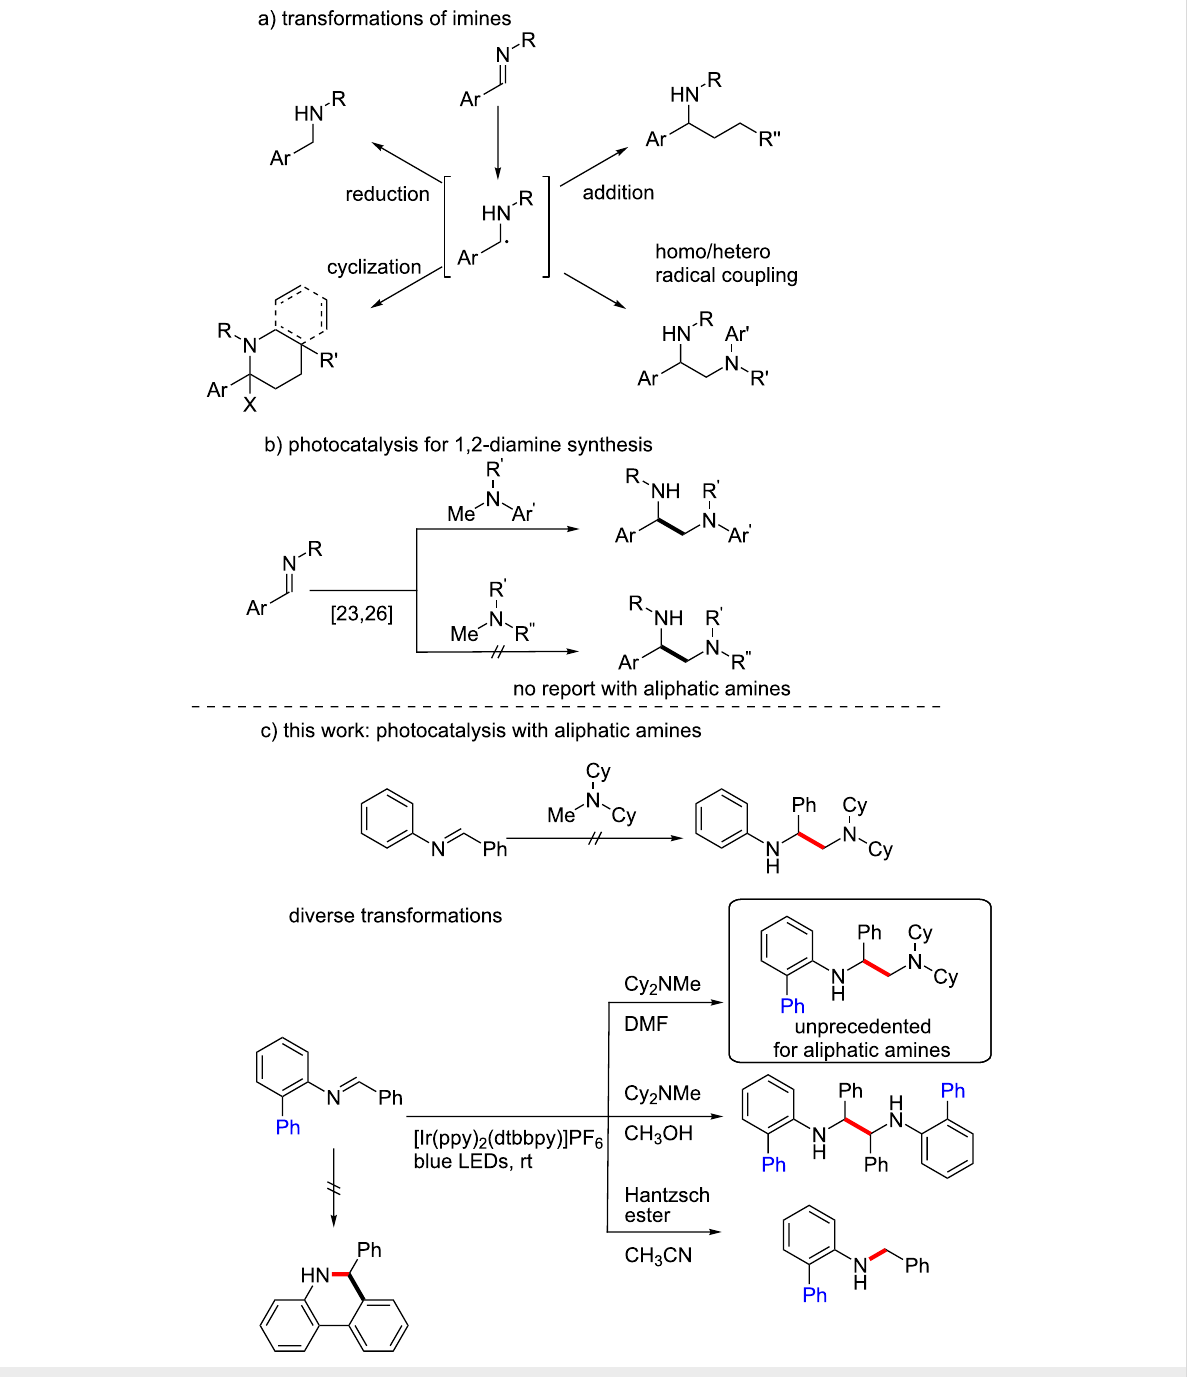
Scheme 1: Photocatalytic transformations of